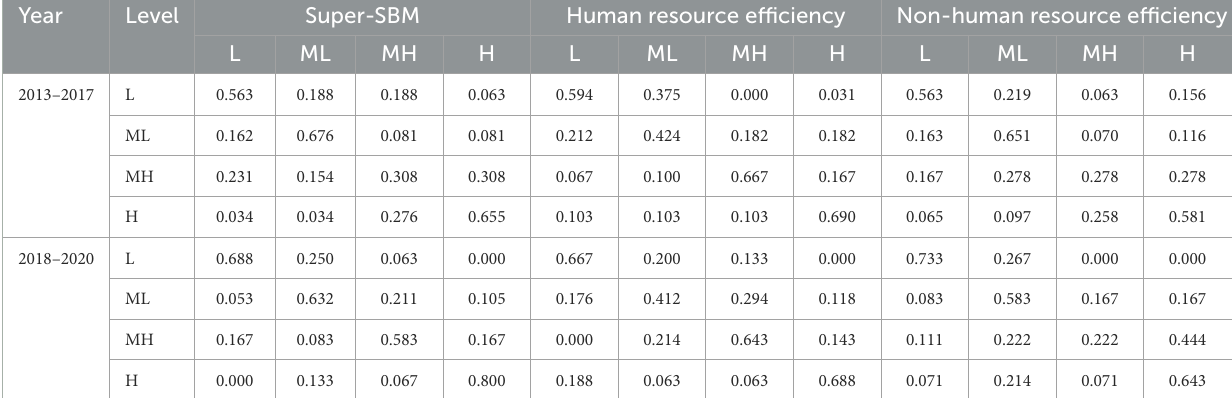
TABLE 3 Dynamic evolution analysis of service efficiency distribution of LTCFs in two time periods (2013–2017 and 2018–2020) in China.